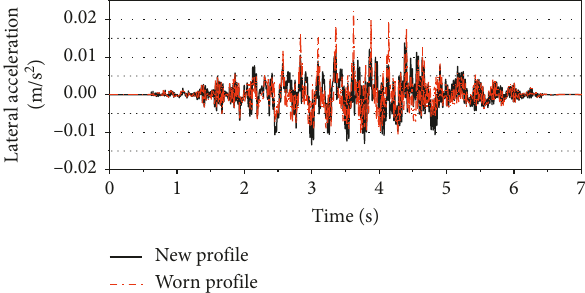
Figure 23: Time histories of vertical acceleration at the midsection of the main span (speed: v � 350km/h).